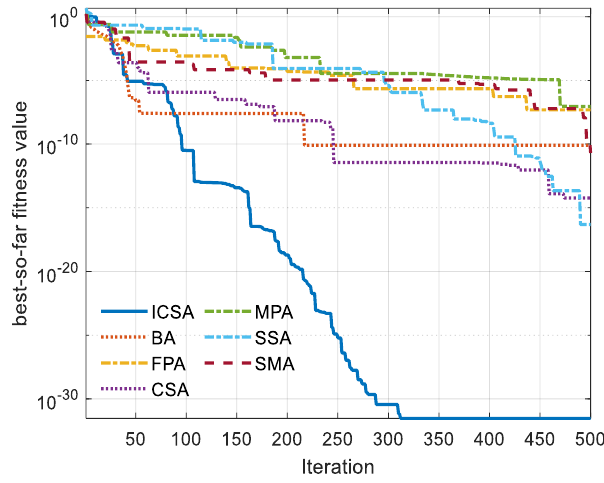
Figure 12. Convergence curve for F12.